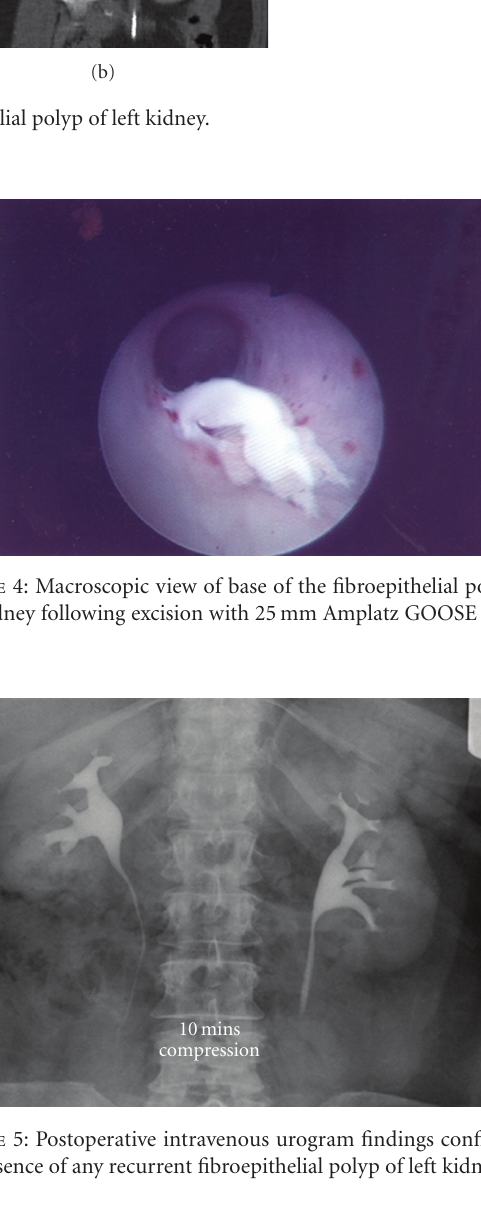
Figure 5: Postoperative intravenous urogram findings confirming the absence of any recurrent fibroepithelial polyp of left